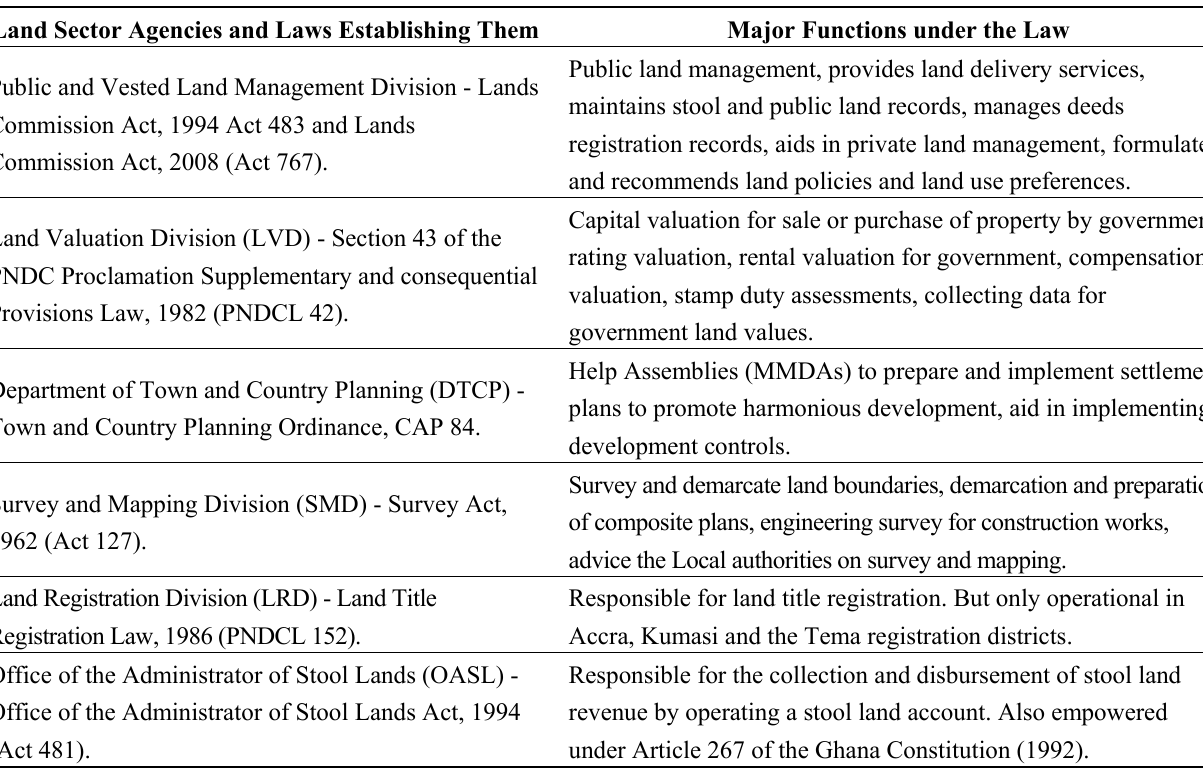
Table 1. Land Sector Agencies in Ghana and their major functions. Source: Own Compilation, 2013. Land Sector Agencies and Laws Establishing